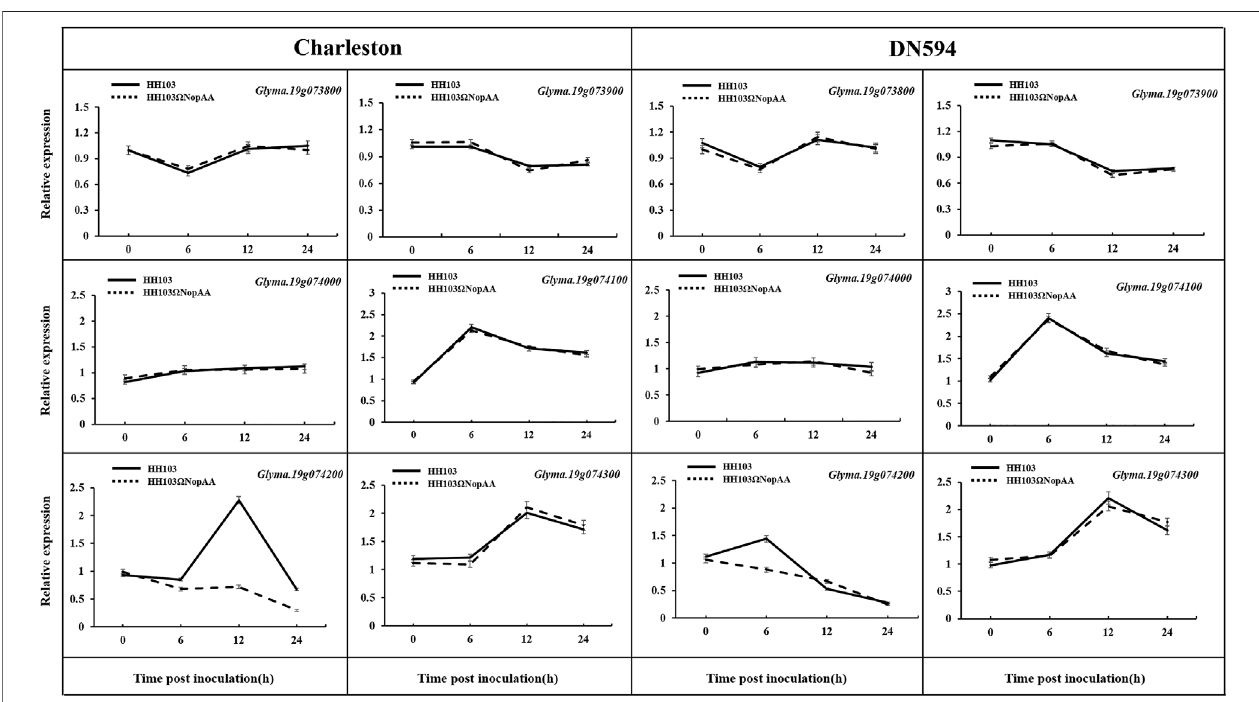
FIGURE3| AnalysisoftherelativeexpressionlevelsofcandidategenesintheQTLintervalbyqRT-PCR.Relativeexpressionofgeneswascalculatedbythe2 − ΔΔ Ct method, and the relative expression levels of each gene were normalized using GmUNK1 ( Glyma.12g020500 ). Data are means ± SE of three replicates.